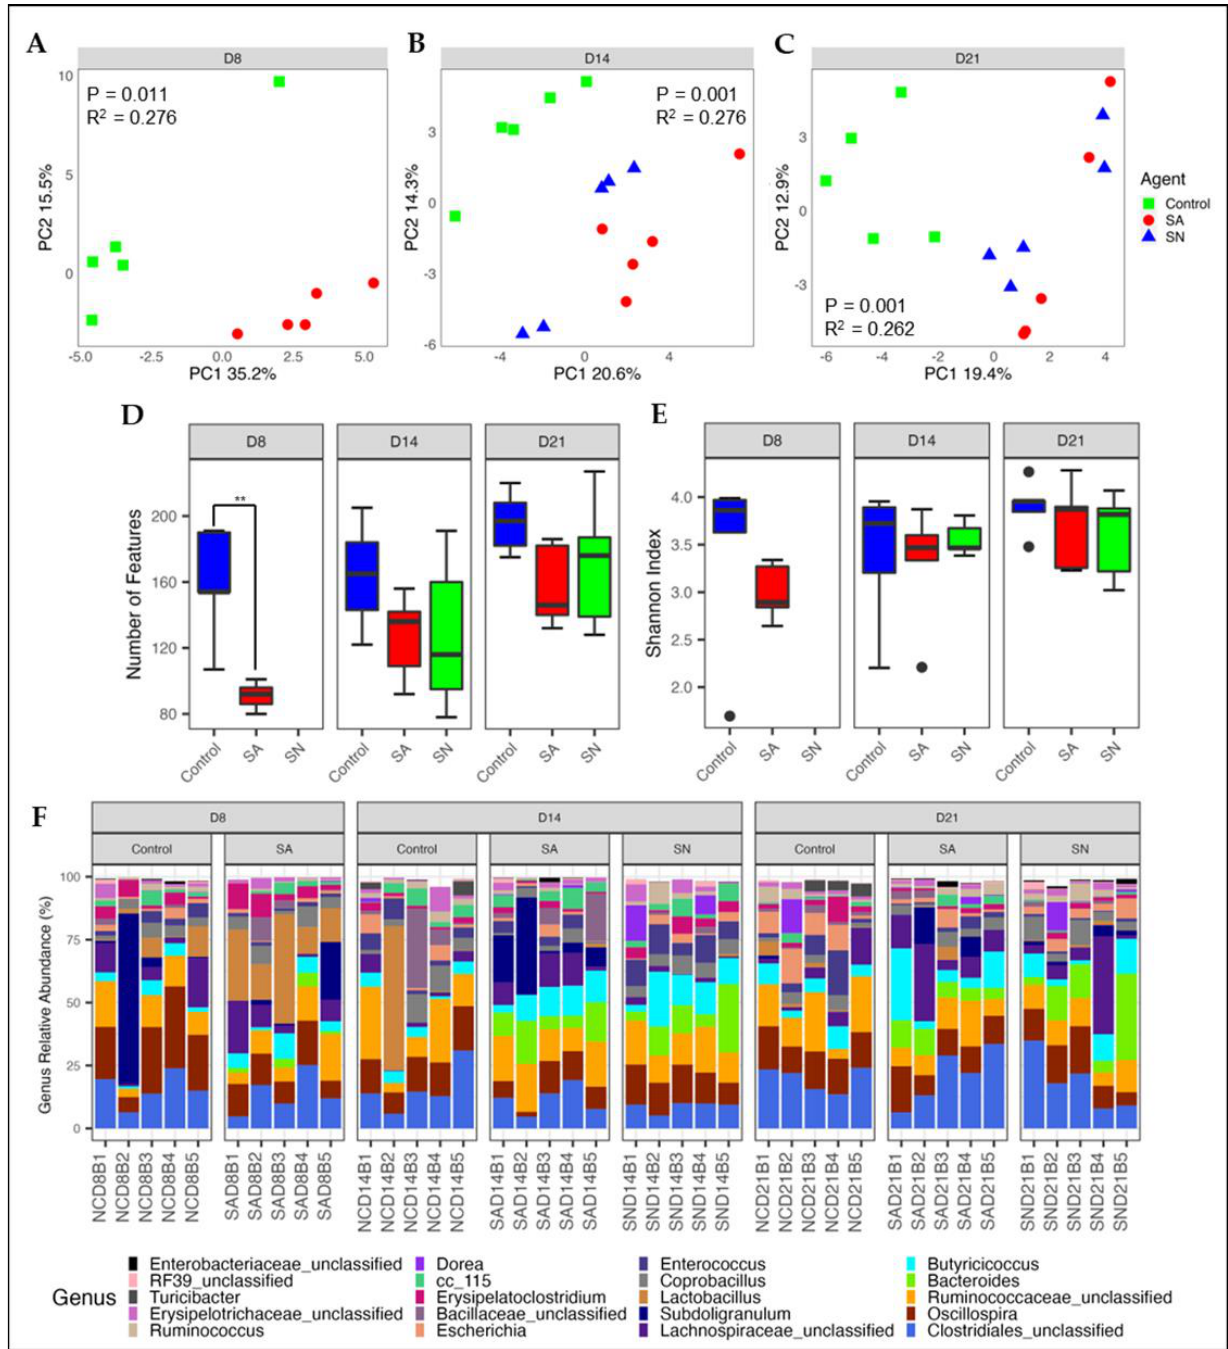
Figure 4. Effect of Salmonella colonization on bacterial diversity. PCA plots were used to visualize differences in bacterial composition between control, Salmonella artificial (SA), and Salmonella natural (SN) groups on days 8 ( A ), 14 ( B ), and 21( C ), as measured by the Euclidean distance between samples. Changes in community richness and evenness were determined using the Observed Features ( D ) and Shannon diversity ( E ) calculators, respectively. Relative abundance was calculated using CSS normalized data, and the top 20 genera are shown ( F ). Significant differences were determined using the permanova and Kruskal-Wallis tests for beta and alpha diversity, respectively. Wilcoxon Rank-Sum tests were used for pairwise comparisons in richness and evenness. Results were considered significant at a p < 0.05. Samples falling outside of the first and third quartiles are shown as black